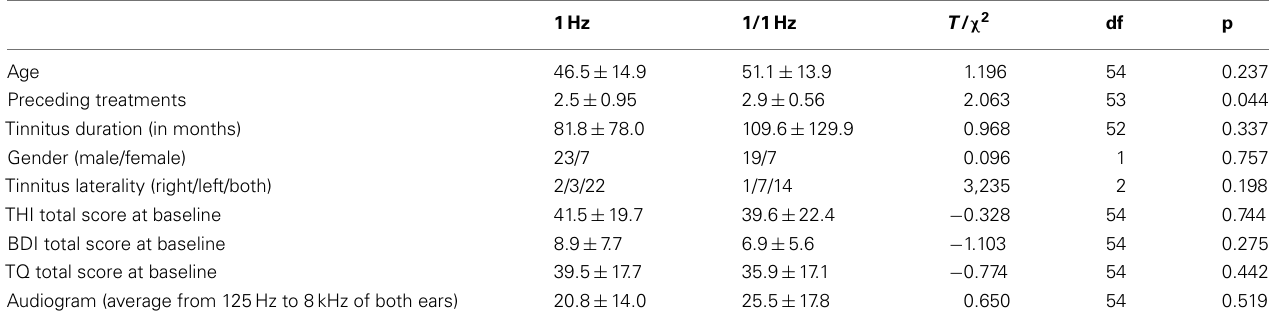
Table 1 | Clinical and demographic characteristics (mean ±